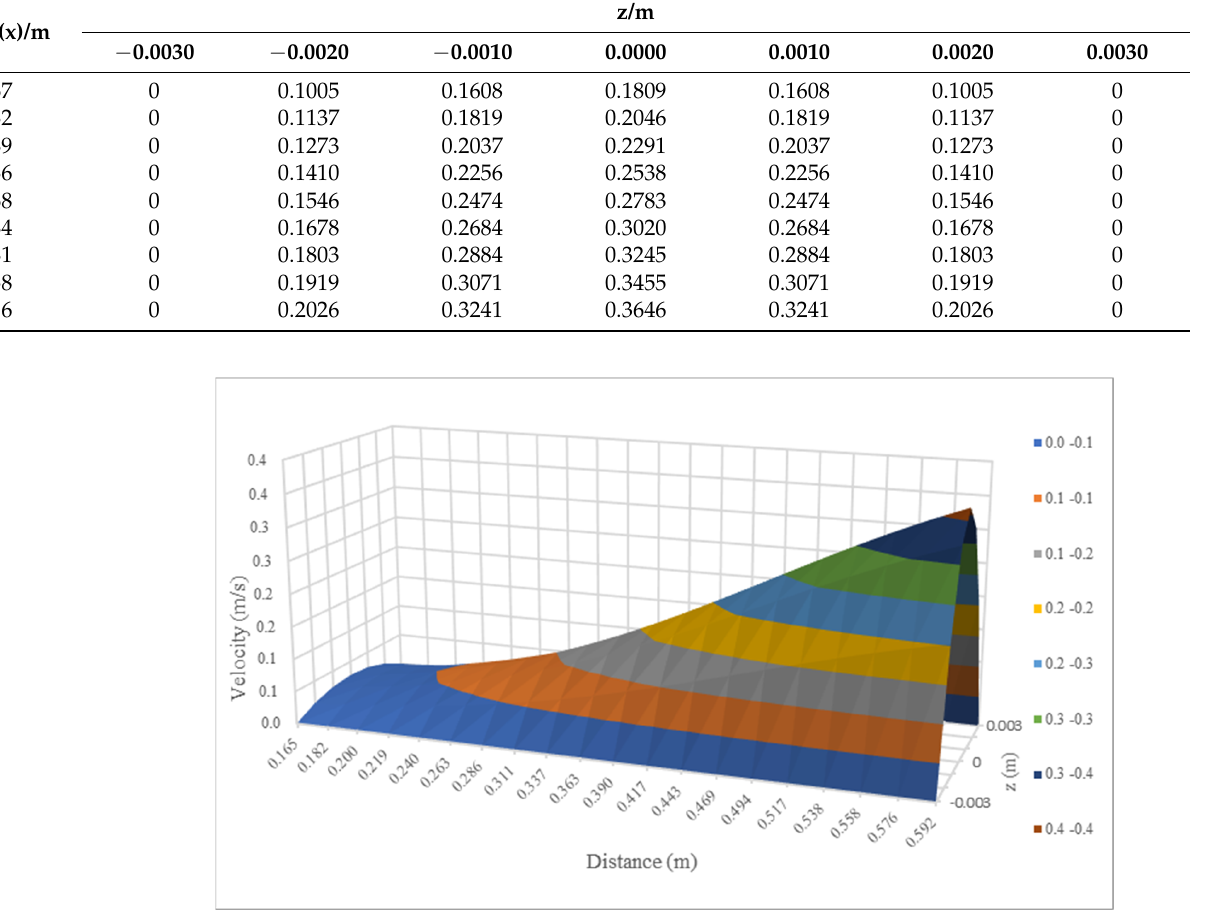
Figure 18. Variation curve of slurry velocity along z-axis at different times.